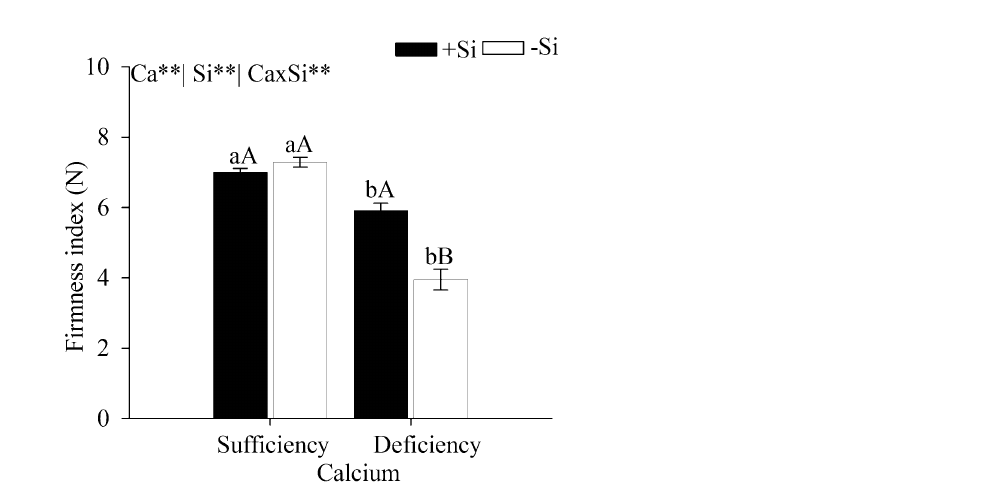
Figure 7. Leaf firmness index on the second day after harvesting of cabbage under Ca sufficiency and Ca deficiency, with (− Si) and without Si (+ Si). F test was applied: *(p ≤ 0.05) and **(p ≤ 0.01). The Student t means comparison test was applied. Lowercase letters ( a , b ) indicate significant differences to calcium within the same level as Si (p < 0.05). Uppercase letters ( A , B ) indicate significant differences for silicon within the same level as Ca ( p < 0.05). The bars represent the mean standard error. n =